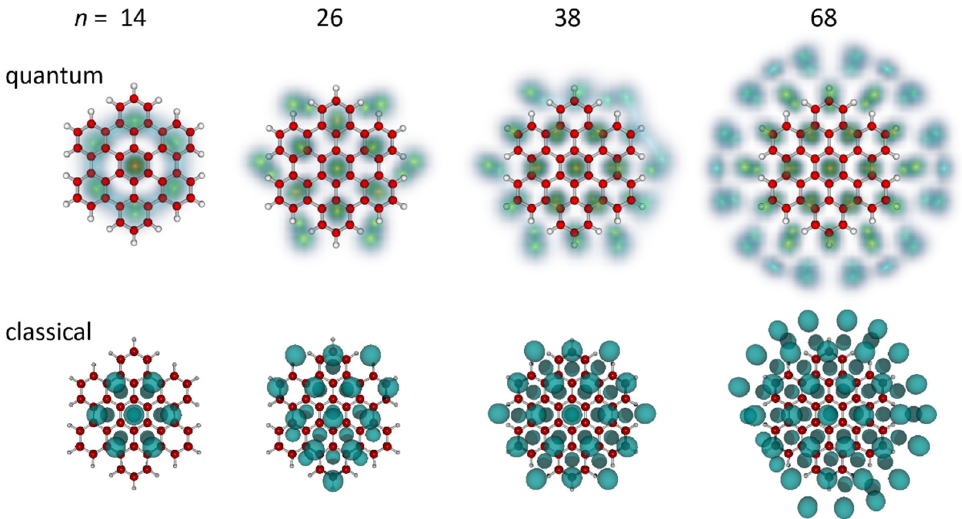
Figure 6. Structures of He n Hbc + for n = 14, 26, 38, and 68 obtained in the quantum and classical calculations (top and bottom row, respectively).